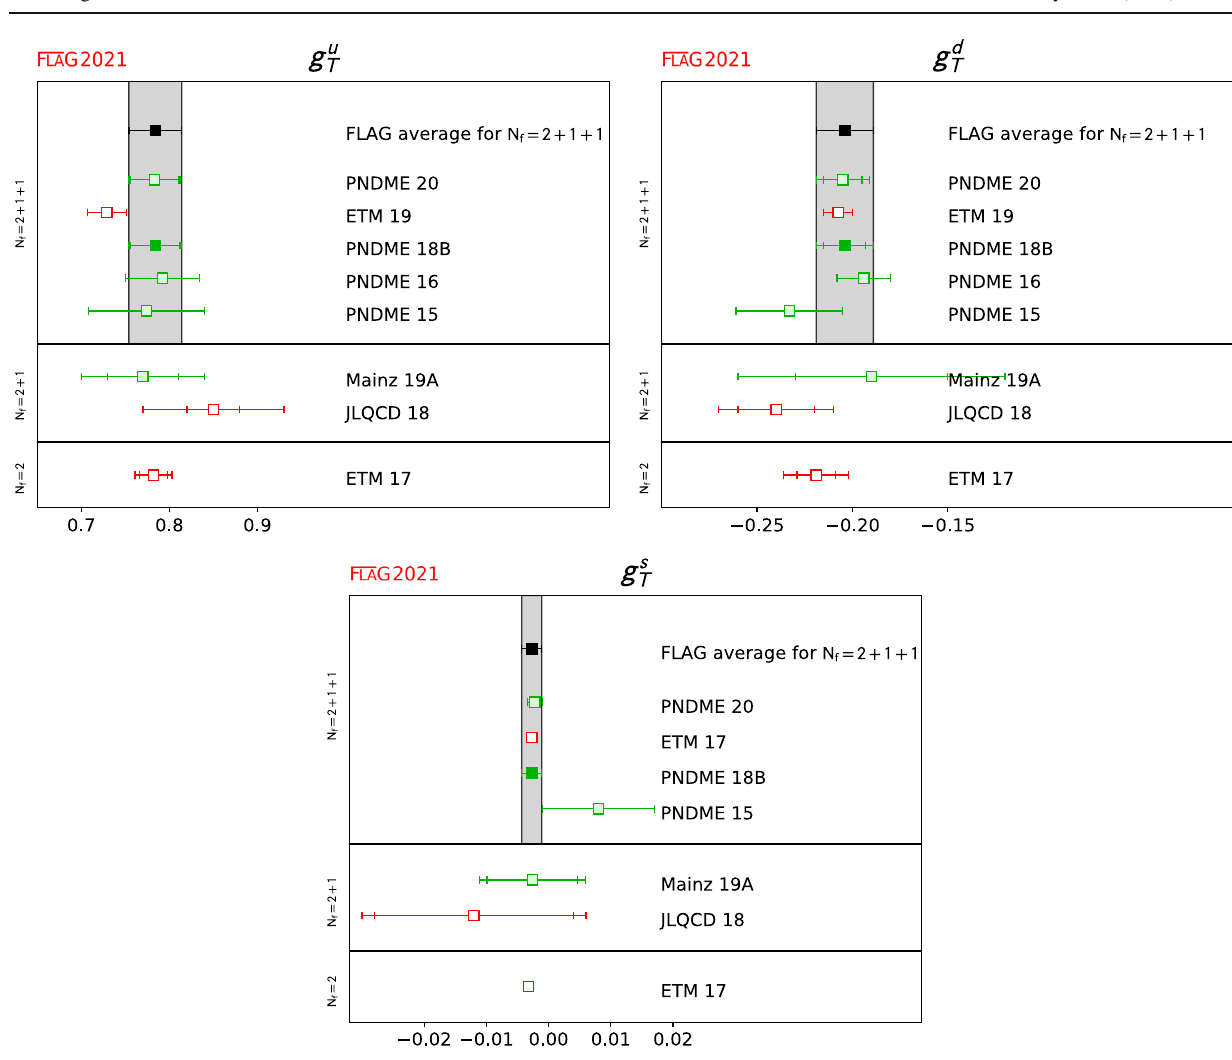
for the N f = 2, 2 + 1, and 2 + 1 + 1 flavour calculations T